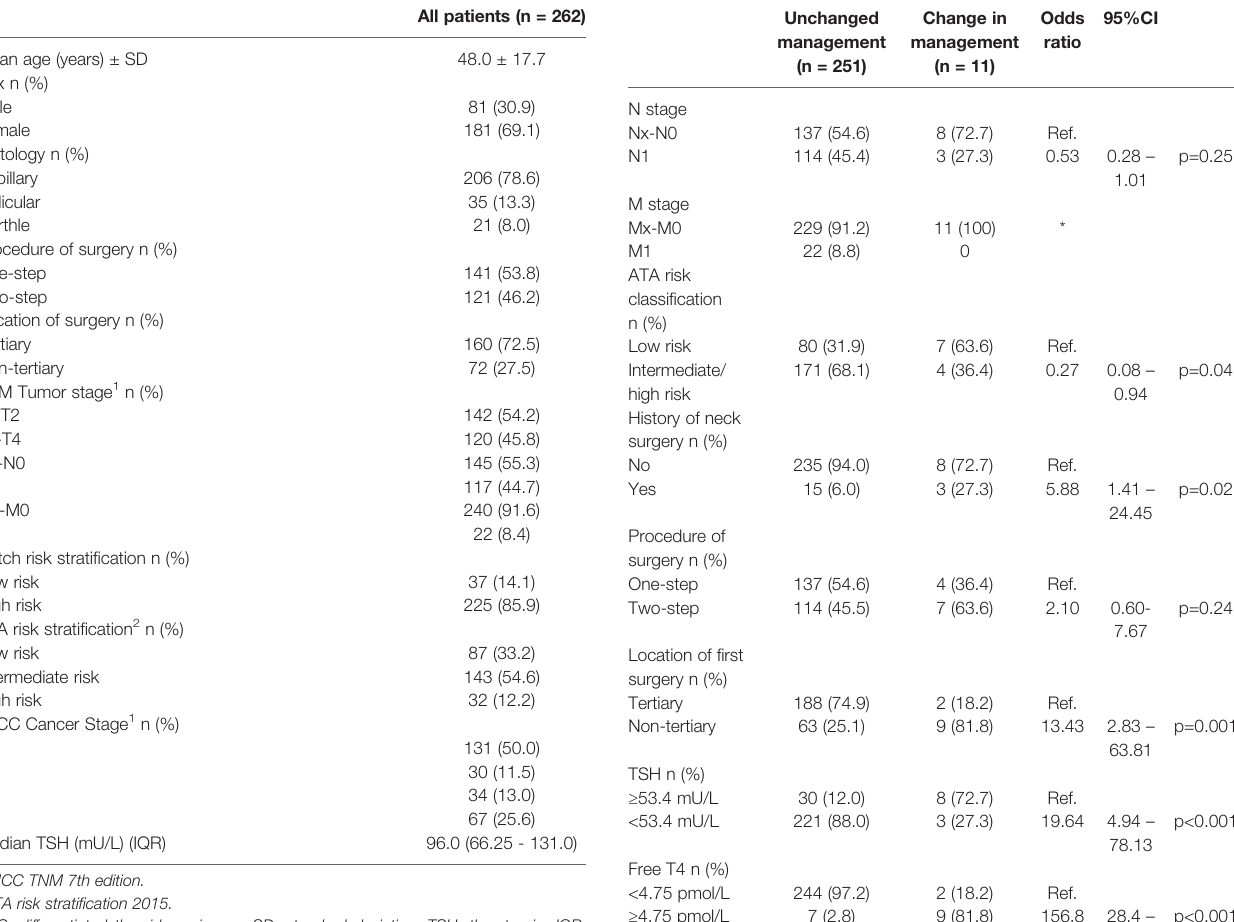
TABLE 1 | Patient characteristics at DTC diagnosis.